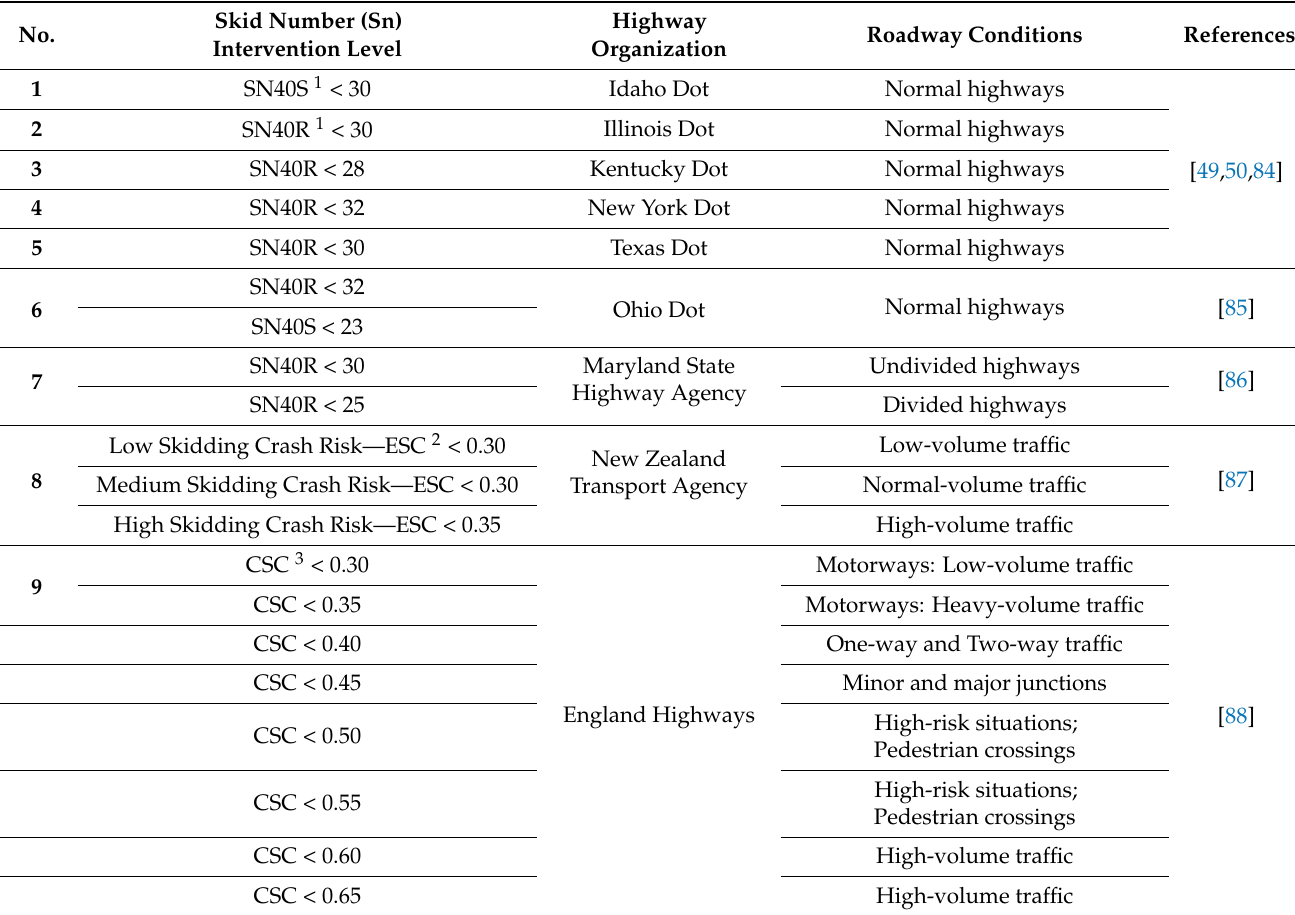
Table 8. Minimum skid resistance intervention level thresholds in different countries (adapted from